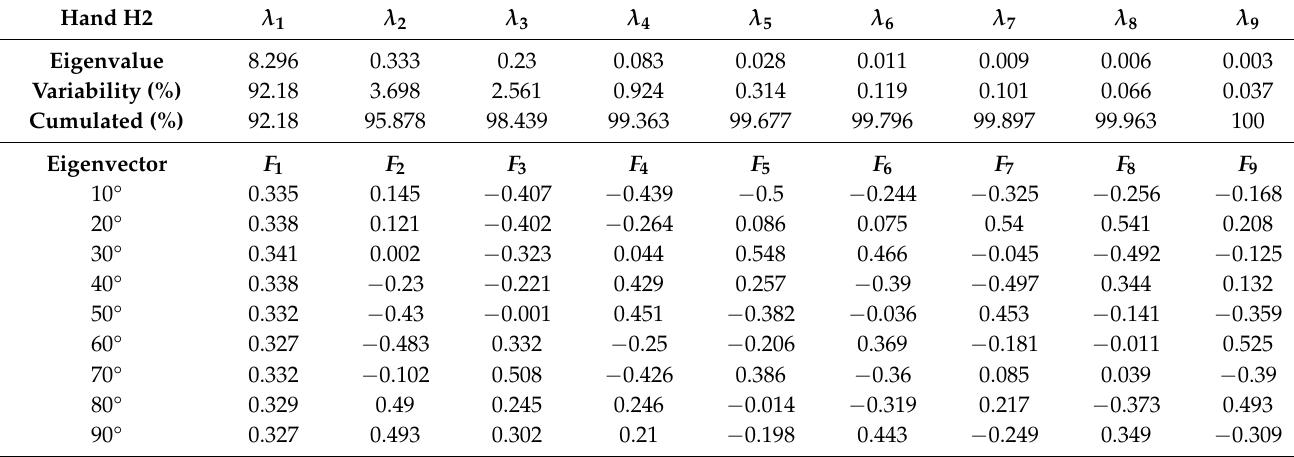
Table 4. PCA results for the H2